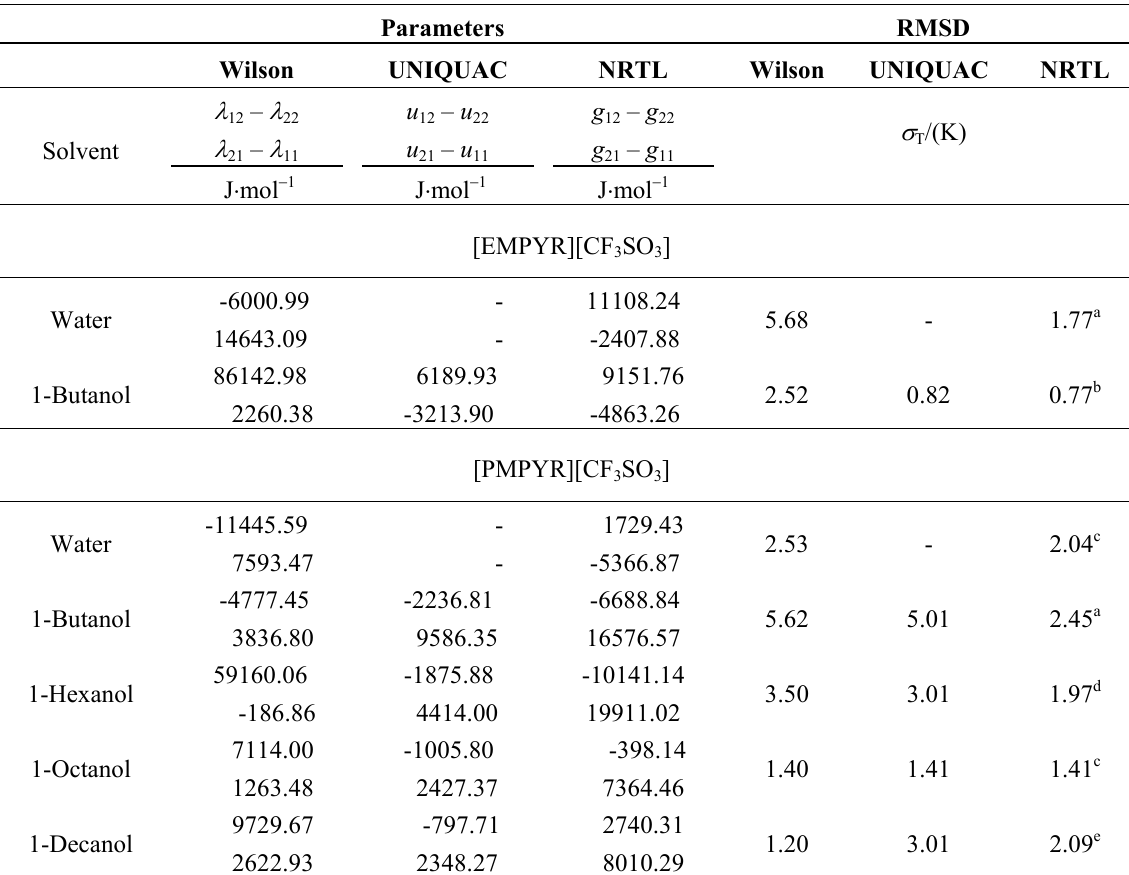
Table 5. Correlation of the (solid + liquid) phase equilibrium data of the {IL + water, or + an alcohol} mixtures by means of Wilson, UNIQUAC and NRTL equations: values of parameters and measures of